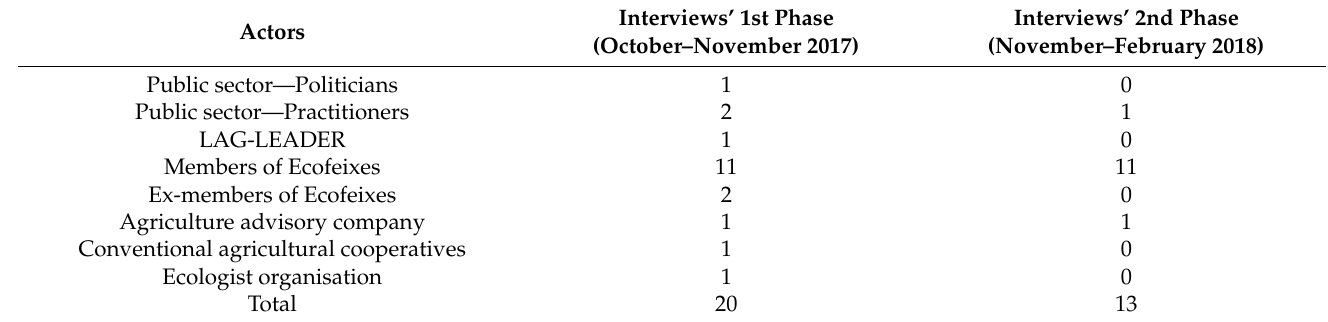
Table 1. Number of interviews. Own